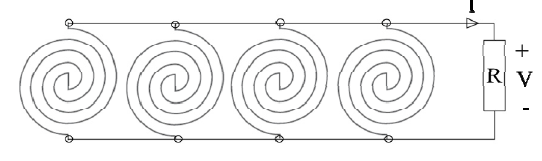
Figure 5. 4-turn spiral TENG in parallel arrays.